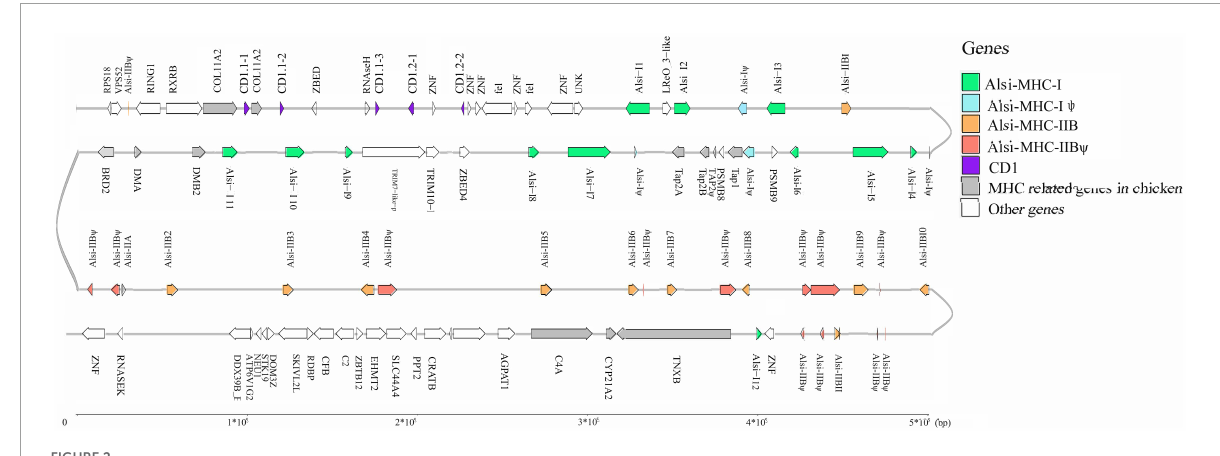
FIGURE2 Gene arrangement in 2M BACs MHC region in Chinese